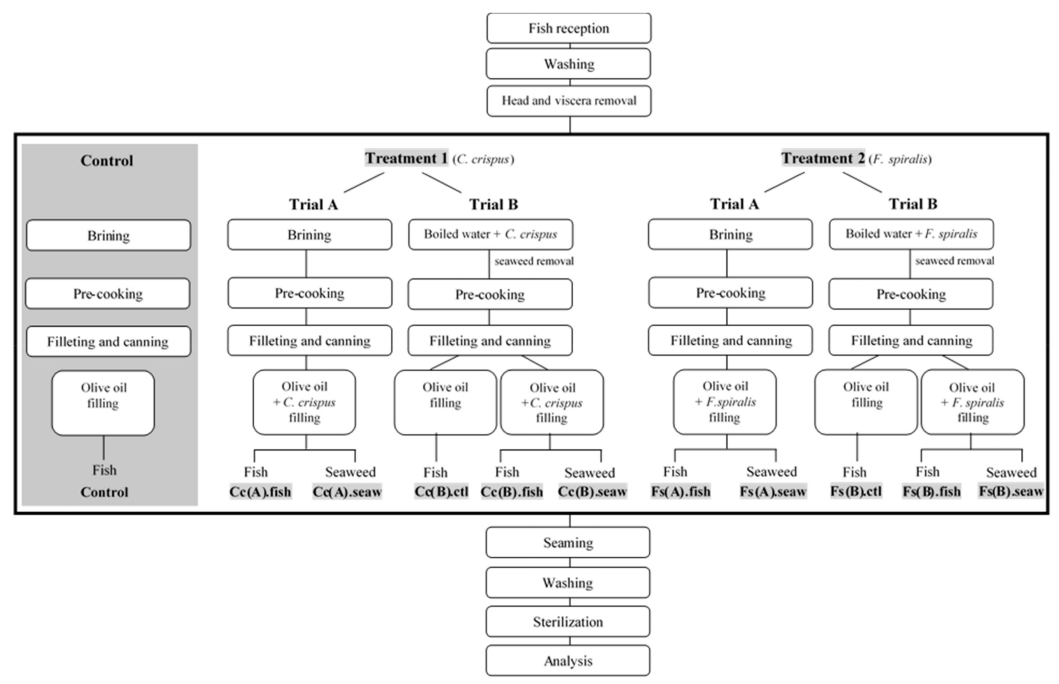
Figure 4. Scheme production for canned chub mackerel produced under the traditional process (Control) and for canned chub mackerel incorporating C. crispus (Treatment 1—Trials A and B) or F. spiralis (Treatment 2—Trials A and B) developed in this work. The respective fish (Cc(A).fish; Fs(A).fish; Cc(B).ctl; Cc(B).fish; Fs(B).ctl and Fs(B).fish) and seaweed (Cc(A).seaw; Fs(A).seaw; Cc(B).seaw and Fs(B).seaw) samples that resulted from Treatments 1 and 2 were analysed separately. For Trial B, the control samples Cc(B).ctl and Fs(B).ctl correspond to chub mackerel boiled with seaweed but without its addition in the filling step.